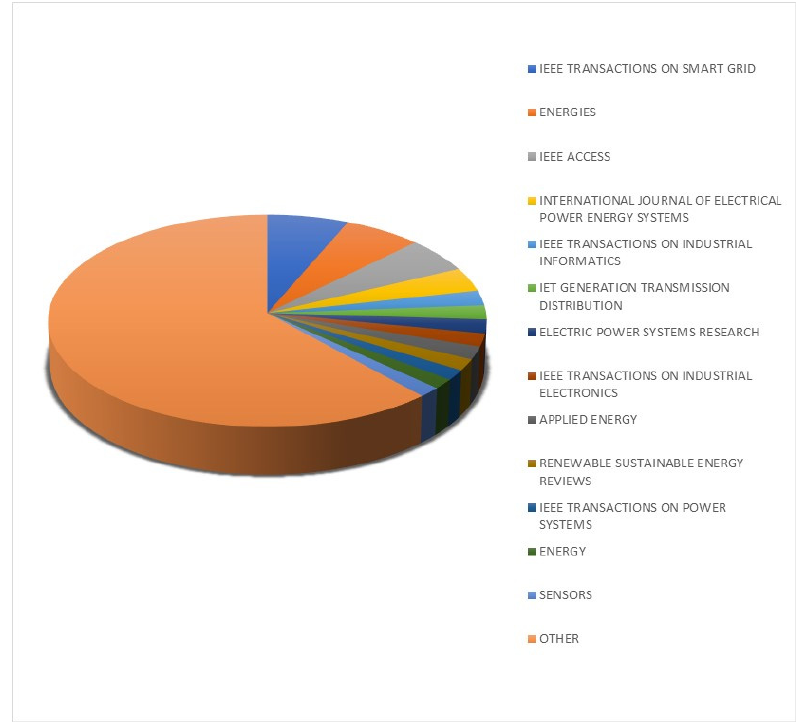
Figure 2. Major publishers in the research topic.